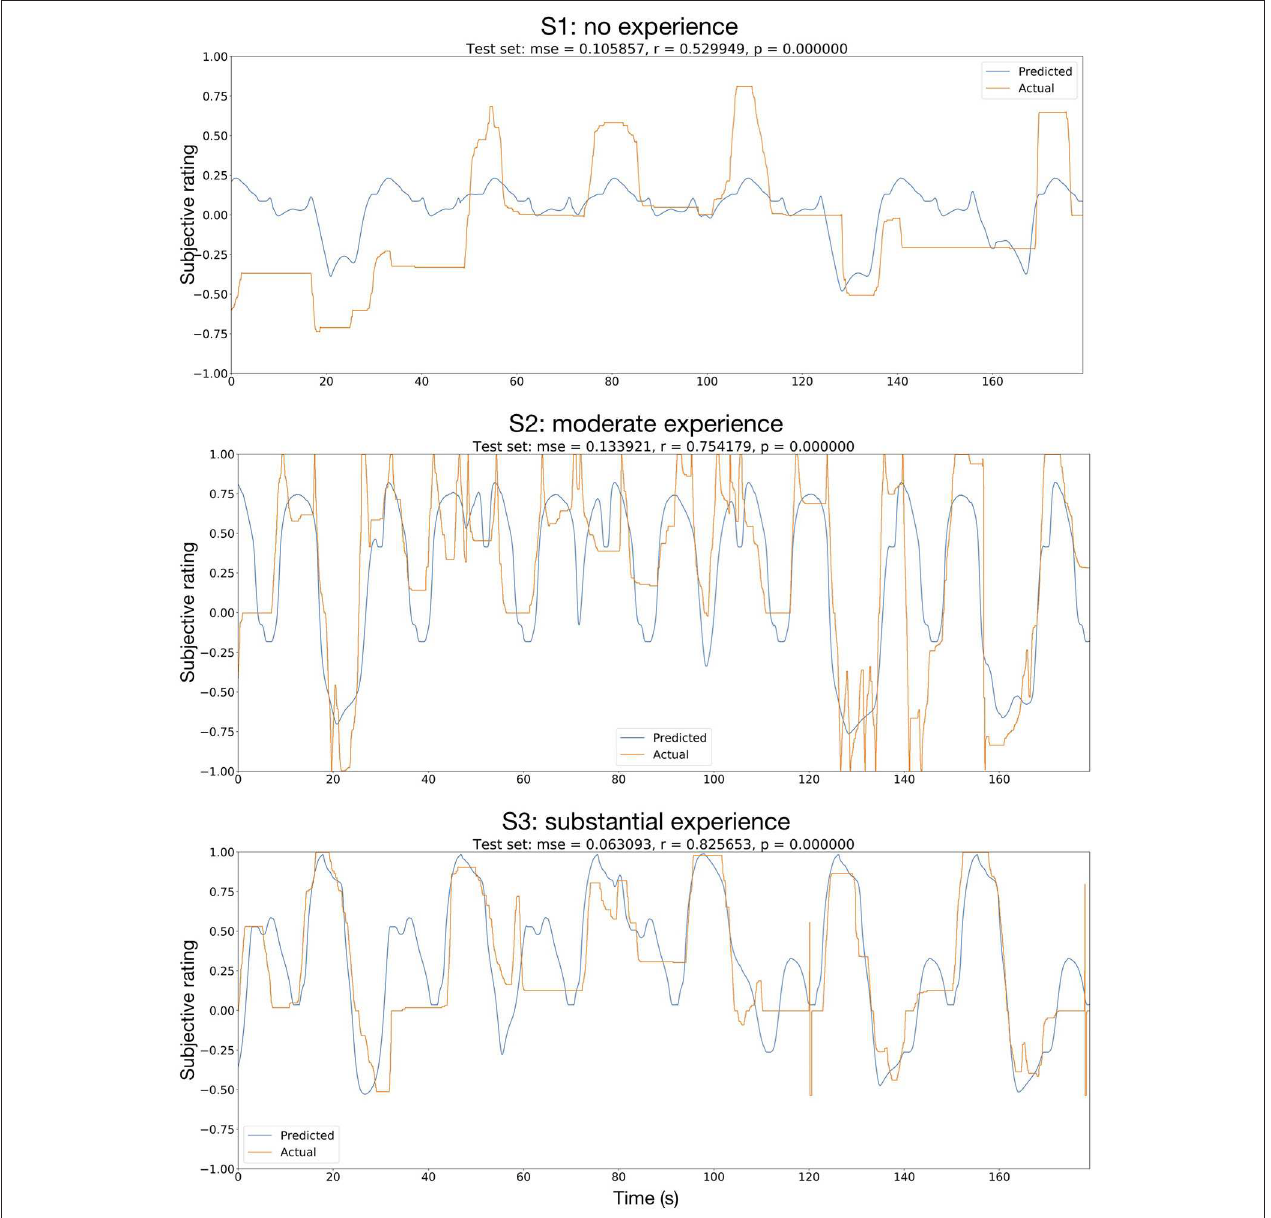
FIGURE 7 | Regression of subjective rating, using the robotic hand position as input. The network used was the Deep4Net, with a predictor time length of 1s. The orange curve shows the actual rating given by the users, the blue curve shows the predicted rating. mse, mean square error; r, Pearson’s ρ ; p, p -value (uncorrected for multiple